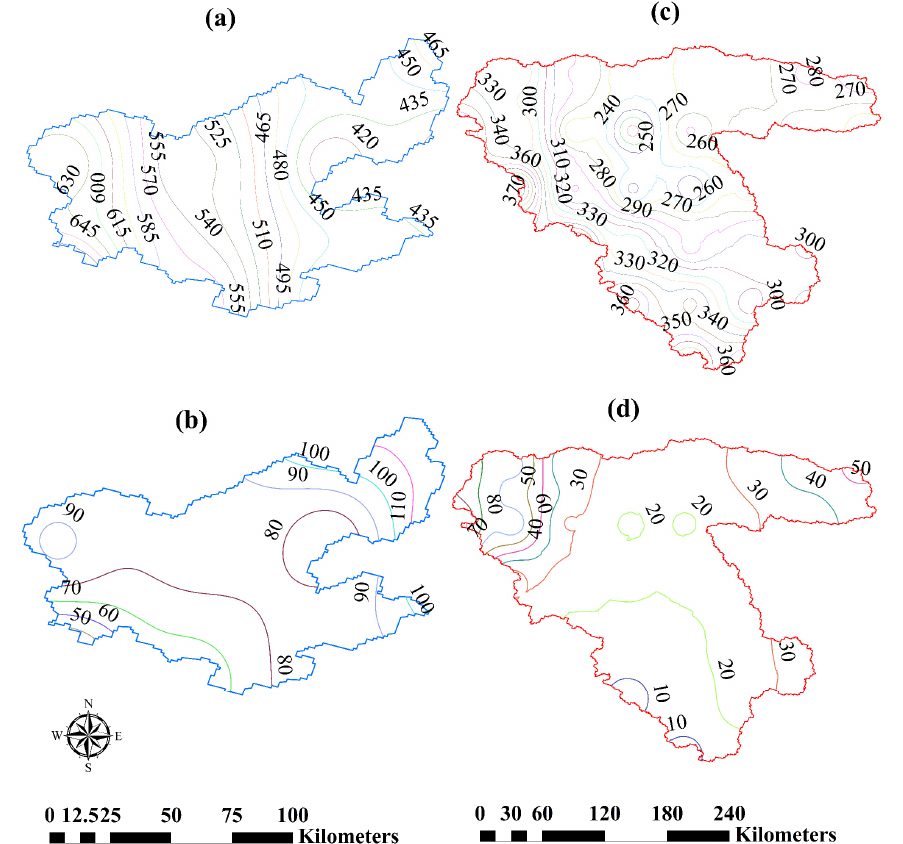
Figure 14. Spatial distribution of rainfall and snowfall (mm) in the LV ( a , b ) and LU basin ( c , d ) respectively, based on [20].